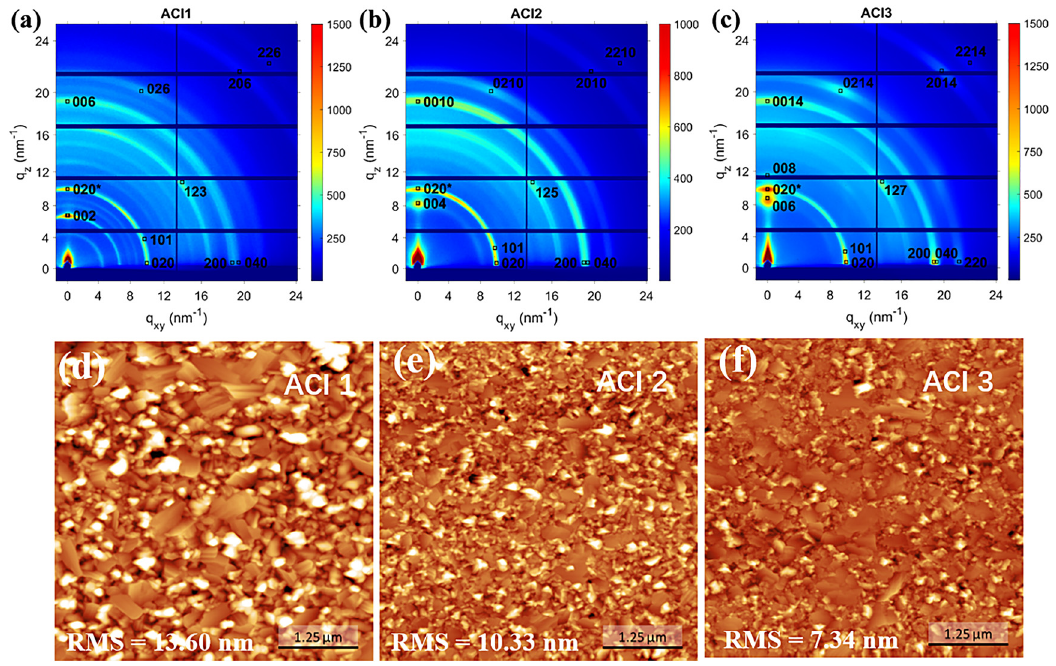
Figure1: (a – c)2DGIWAXSpatternsof(GA)(MA) n Pb n I 3n + 1 (ACI, n =1 – 3) fi lmsacquiredattheincidenceangleof0.5 ° .There fl ectionsareindexed according to the adjusted unit cell parameters given in Table S1, (d – f) AFM images (5 × 5 μ m) and RMS roughness of the ACI fi lms (roughness with standard deviation, ACI 1: 13.60 ± 5.53 nm, ACI 2: 10.33 ± 2.46 nm, ACI 3: 7.34 ± 1.98 nm).